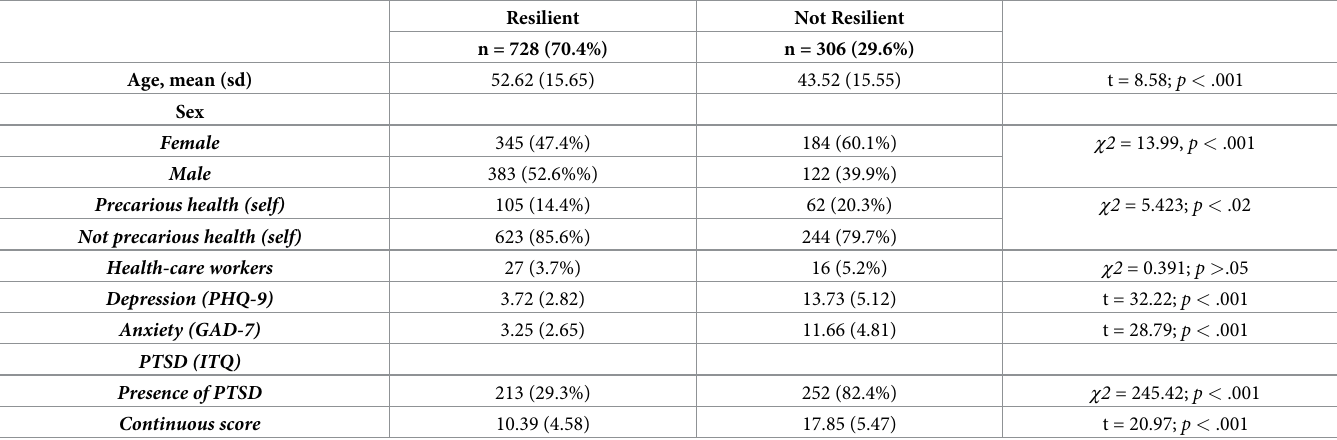
Table 3. Descriptives of the resilient and not resilient